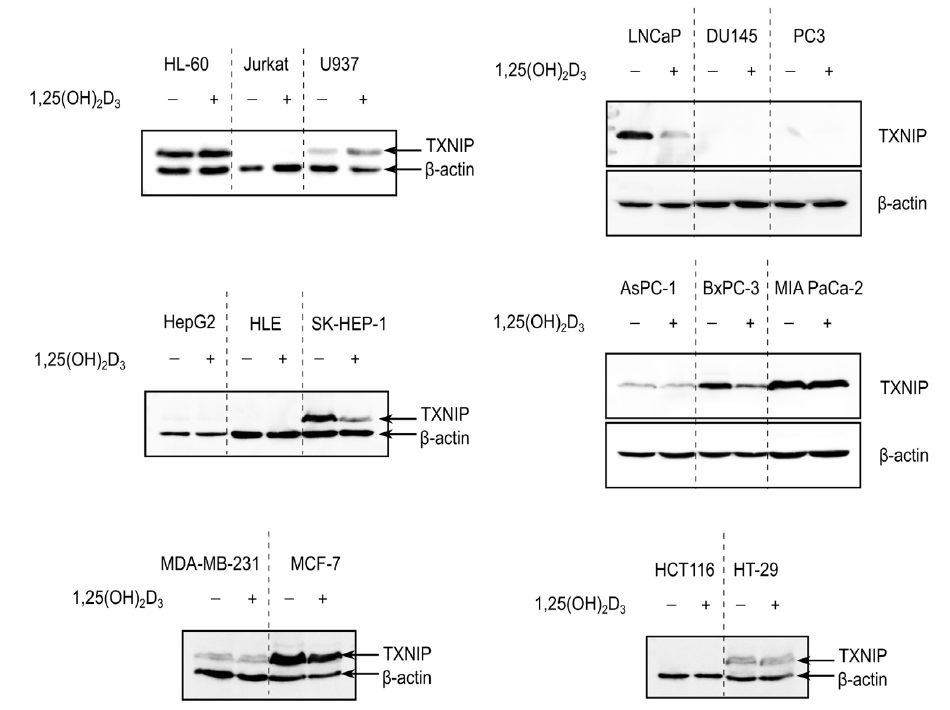
Figure 1. TXNIP is differentially regulated by 1,25(OH) 2 D 3 in cancer cells. Immunoblots showing TXNIP protein levels in cancer cells of various tissue origins—hematological (HL-60, Jurkat, U937), prostate (LNCaP, DU145, PC3), liver (HepG2, HLE, SK-HEP-1), pancreatic (AsPC-1, BxPC-3, MIA PaCa-2), breast (MDA-MB-231, MCF-7), and colorectal (HCT116, HT-29)—after treatment with 100 nM 1,25(OH) 2 D 3 for 72 h. In several cell lines, e.g., Jurkat cells, TXNIP is not detected and thus no influence of 1,25(OH) 2 D 3 on its expression can be observed. In cases were basal levels are detected, 1,25(OH) 2 D 3 either induced, reduced, or had no clear effect on TXNIP expression, e.g., U937, MCF-7, and HT-29, respectively. “+” and “ − ” denote the presence or absence of the indicated molecule/treatment,